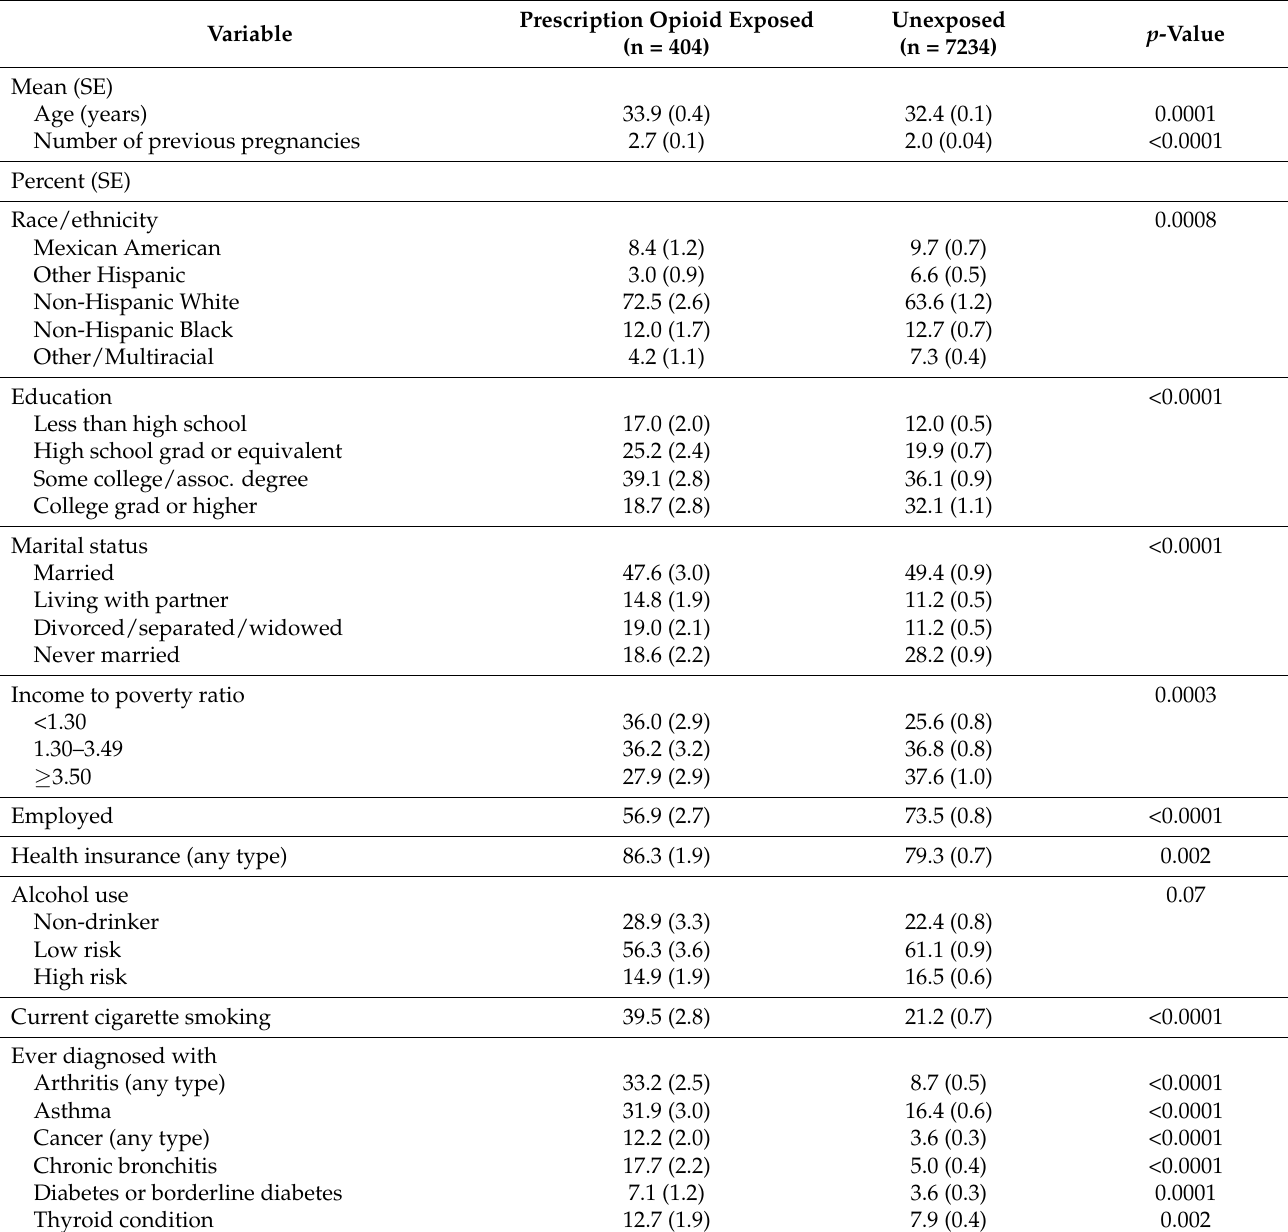
Table 1. Demographic and health history characteristics of reproductive-age women by prescription opioid use status, NHANES